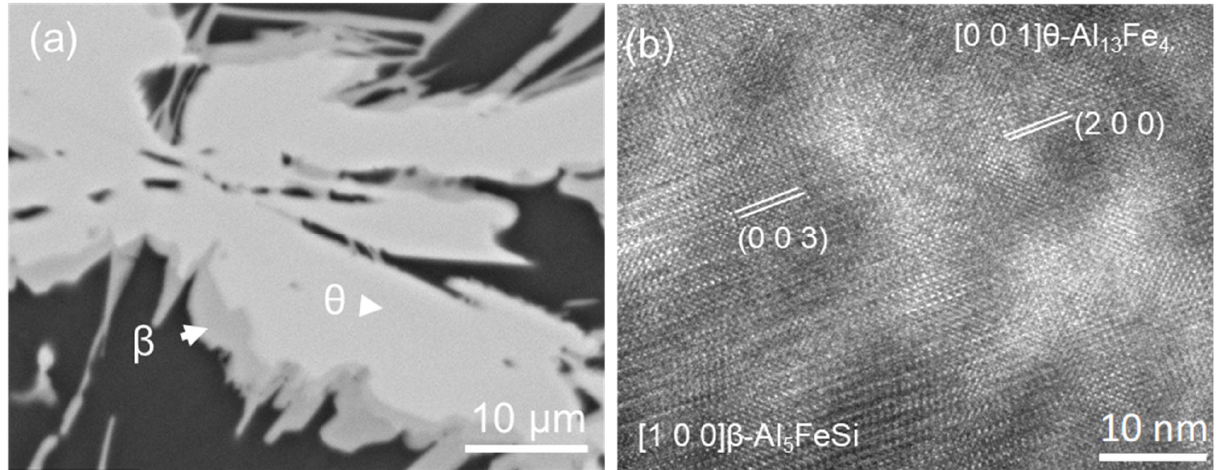
Figure 14. One ‐ step phase transformation between θ‐ Al 13 Fe 4 and β‐ Al 5 FeSi. ( a ) SEM ‐ BSE image showing the microstructure of primary θ‐ Al 13 Fe 4 phase in Al ‐ 4Si ‐ 4Fe alloy solidified at 3.5 K/s—the primary θ‐ Al 13 Fe 4 phase had transformed into the other FIMCs from the edge to centre with plate ‐ like morphology; and ( b ) HRTEM image of the β‐ Al 5 FeSi/Al 13 Fe 4 interface viewed along the zone direction of [0 0 1] of Al 13 Fe 4 and [1 0 0] of β‐ Al 5 FeSi showing the orientation relationship between β‐ Al 5 FeSi and θ‐ Al 13 Fe 4 [80].